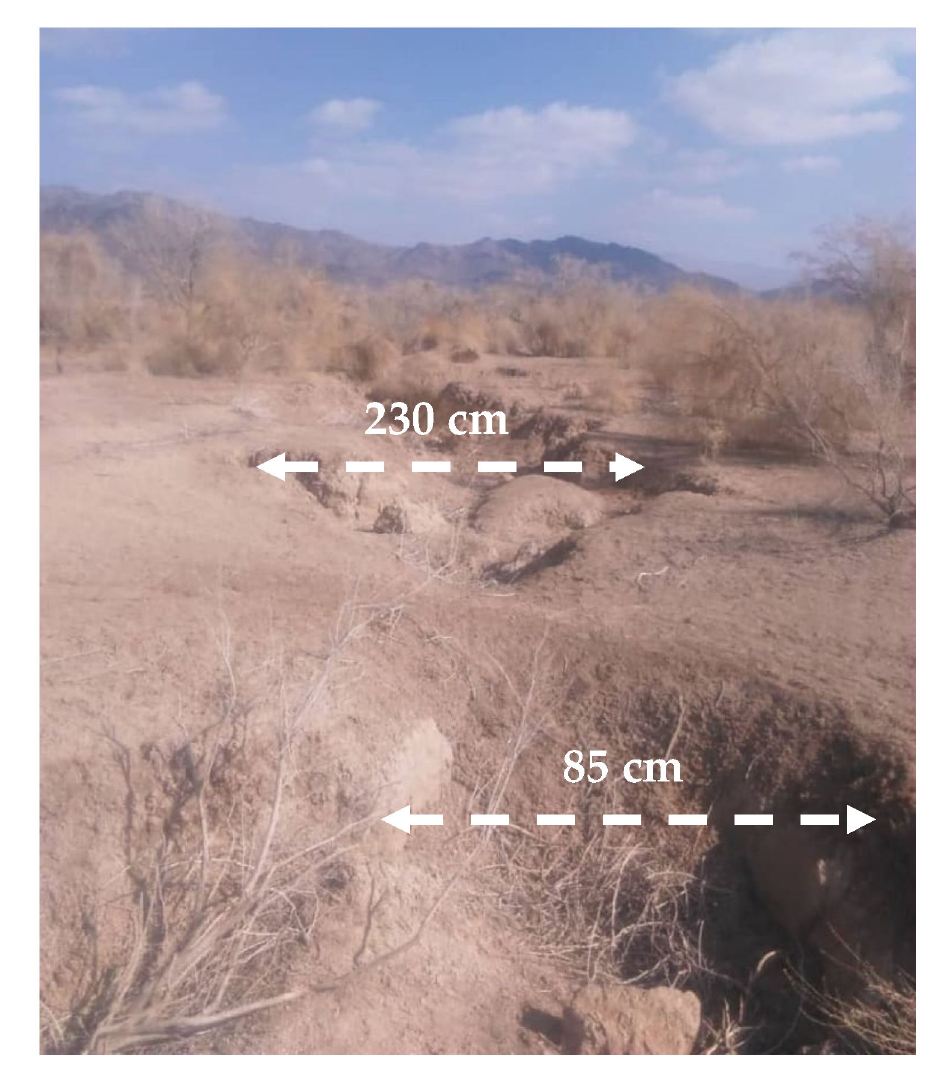
Figure 2. Land subsidence (LS) occurrence. The first author took this photograph in the Bakhtegan basin on 18 June